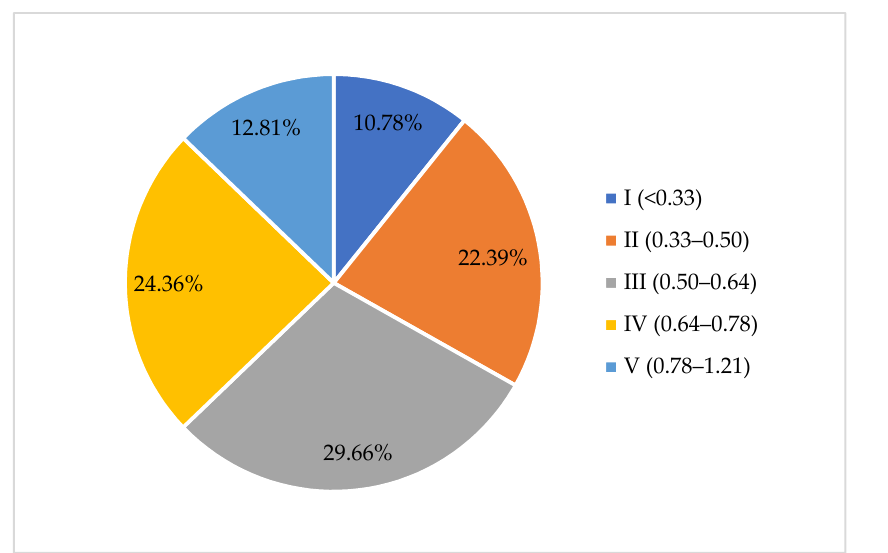
Figure 10. Terrain index values classified according to levels and their respective proportions for various locations in Shiyan.